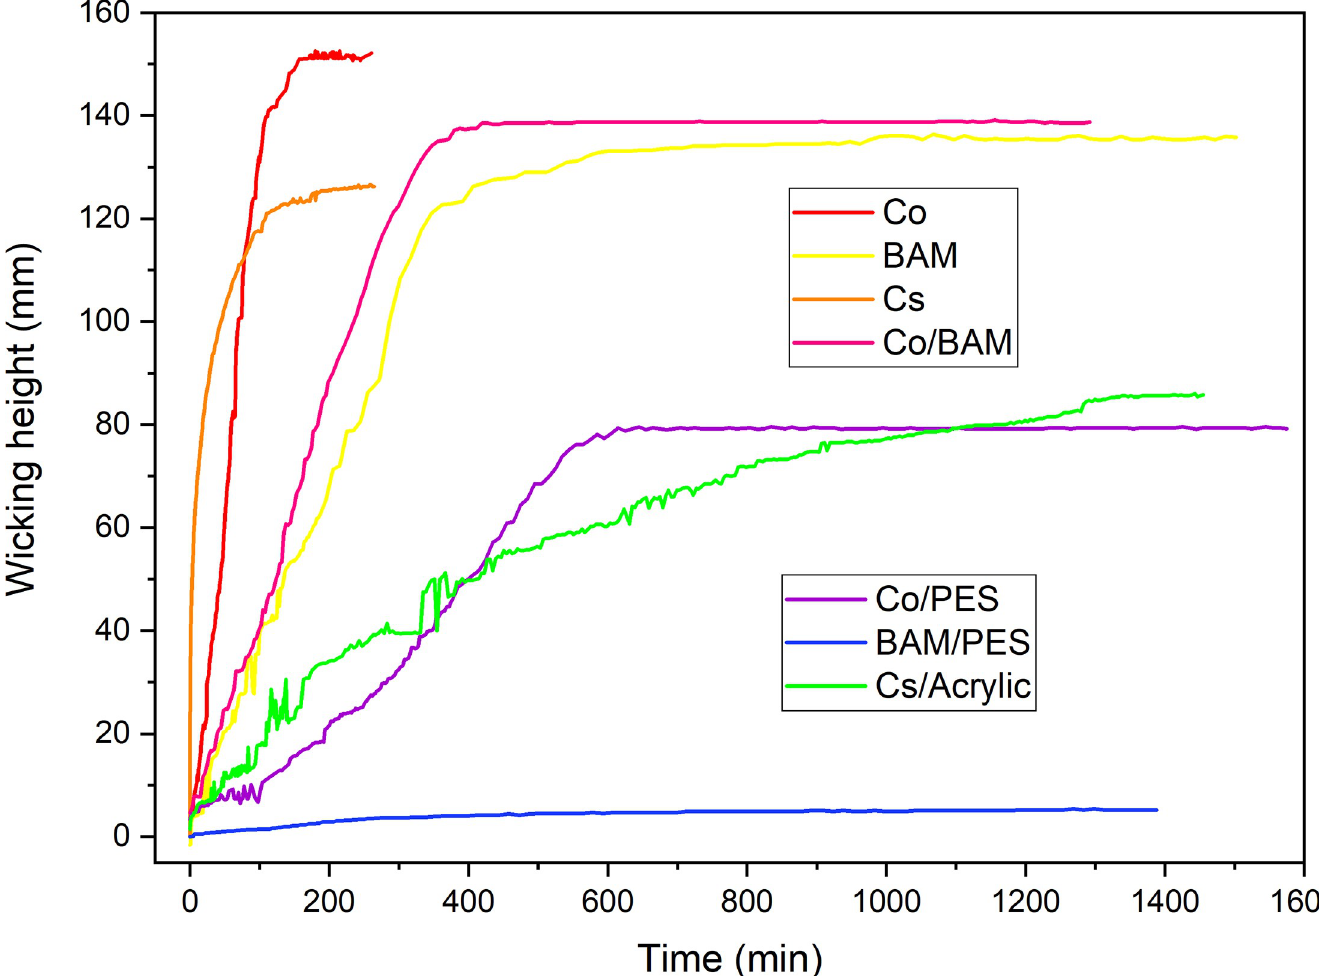
Fig 13. Example of experimental determination of the wicking height of different knitted fabrics (Co-Cotton, BAM-Bamboos, Cs-Hemp), and blended composition (Co/BAM, Co/PES-polyester, BAM/PES and Cs/Acrylic).